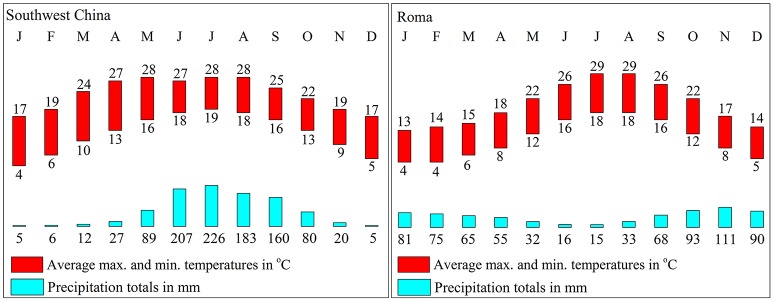
Rainfall and temperature in southwest China and the Mediterranean region. The data are from the China Meteorological Administration and World Meteorological Organization.